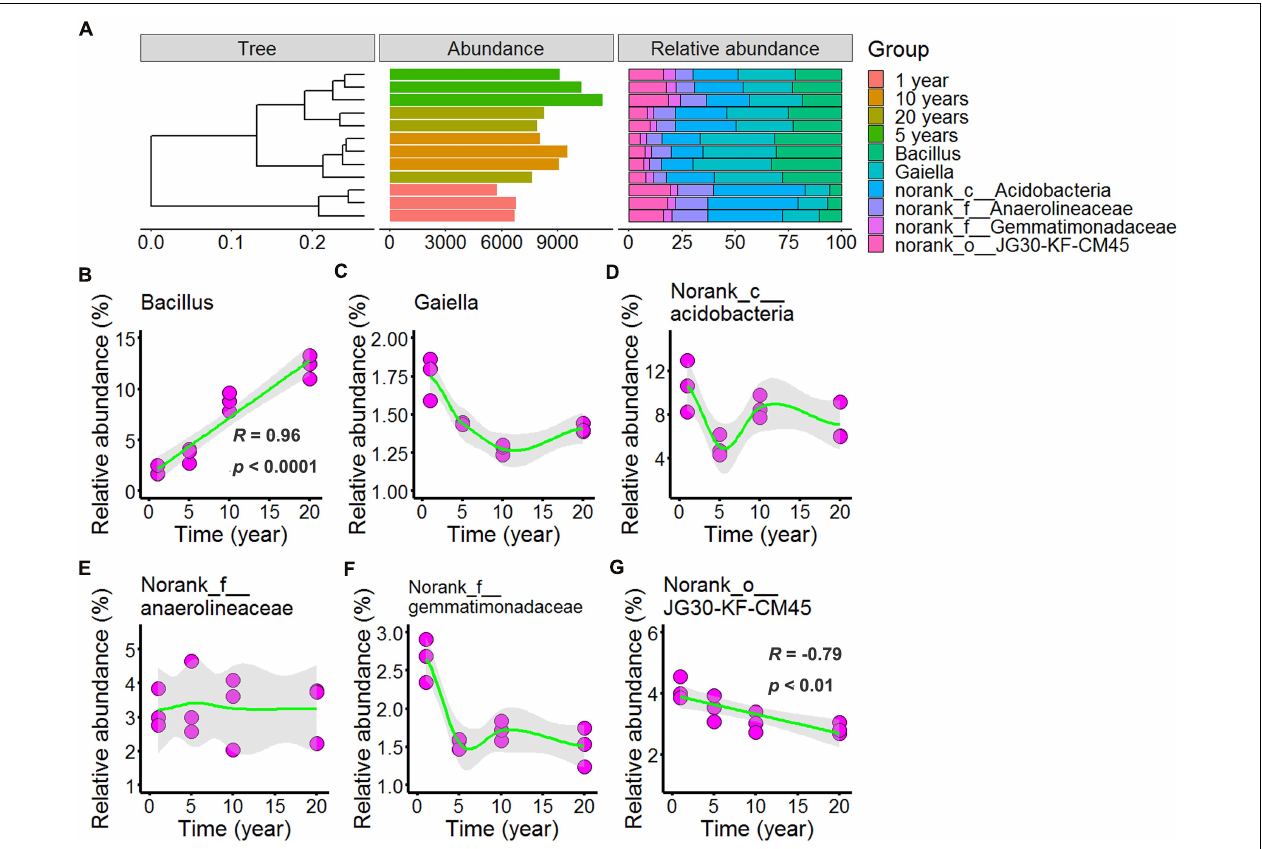
FIGURE 5 | Effect of long-term chili monoculture on the dominant bacteria in rhizosphere soil. The “Abundance” in panel (A) was the total abundance of operational taxonomic units (OTUs). Long-term chili monoculture altered the relative abundance of Bacillus (B) , Gaiella (C) , norank_c__Acidobacteria (D) , norank_f__Anaerolineaceae (E) , norank_f__Gemmatimonadaceae (F) , and norank_ ◦ __JG30-KF-CM45 (G) . The relative abundances of dominant soil bacteria at the genus level of the taxonomic classification showed a nonlinear pattern in response to continuous cropping duration (1, 5, 10, and 20 years). Solid lines represent linear or LOESS fits, and gray areas denote the 95% confidence